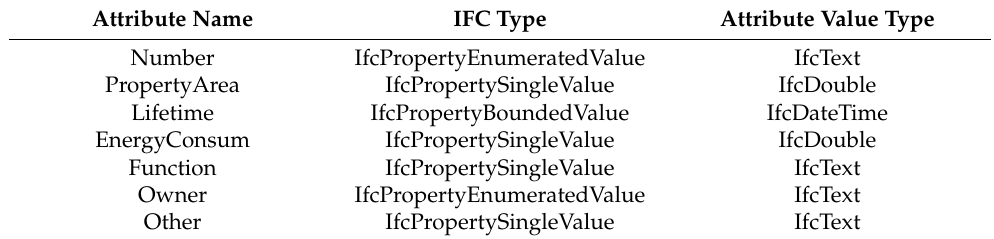
Table 5. Set_ SocialProperty.